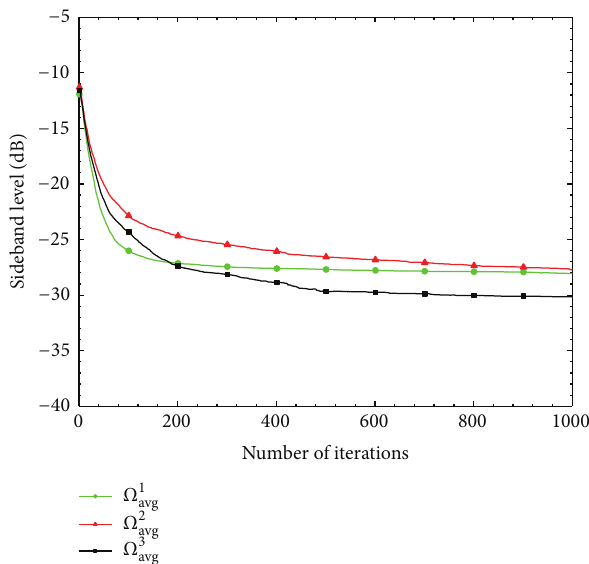
Figure23:SidebandlevelvariationofthethreemethodsforJSCIS— Ω 𝑘 represents the maximum sideband level and 𝑘 represents the method used, where 𝑘 = 1 : SBL, 𝑘 = 2 : SR, and 𝑘 = 3 :